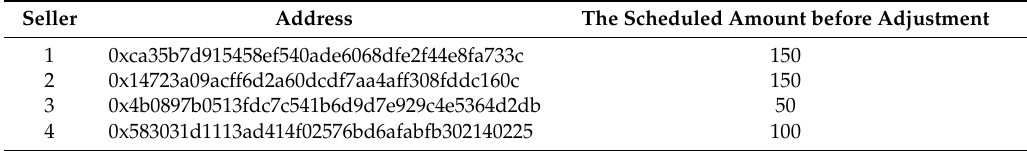
Table 8. Sellers’ scheduled energy amount before adjustment.